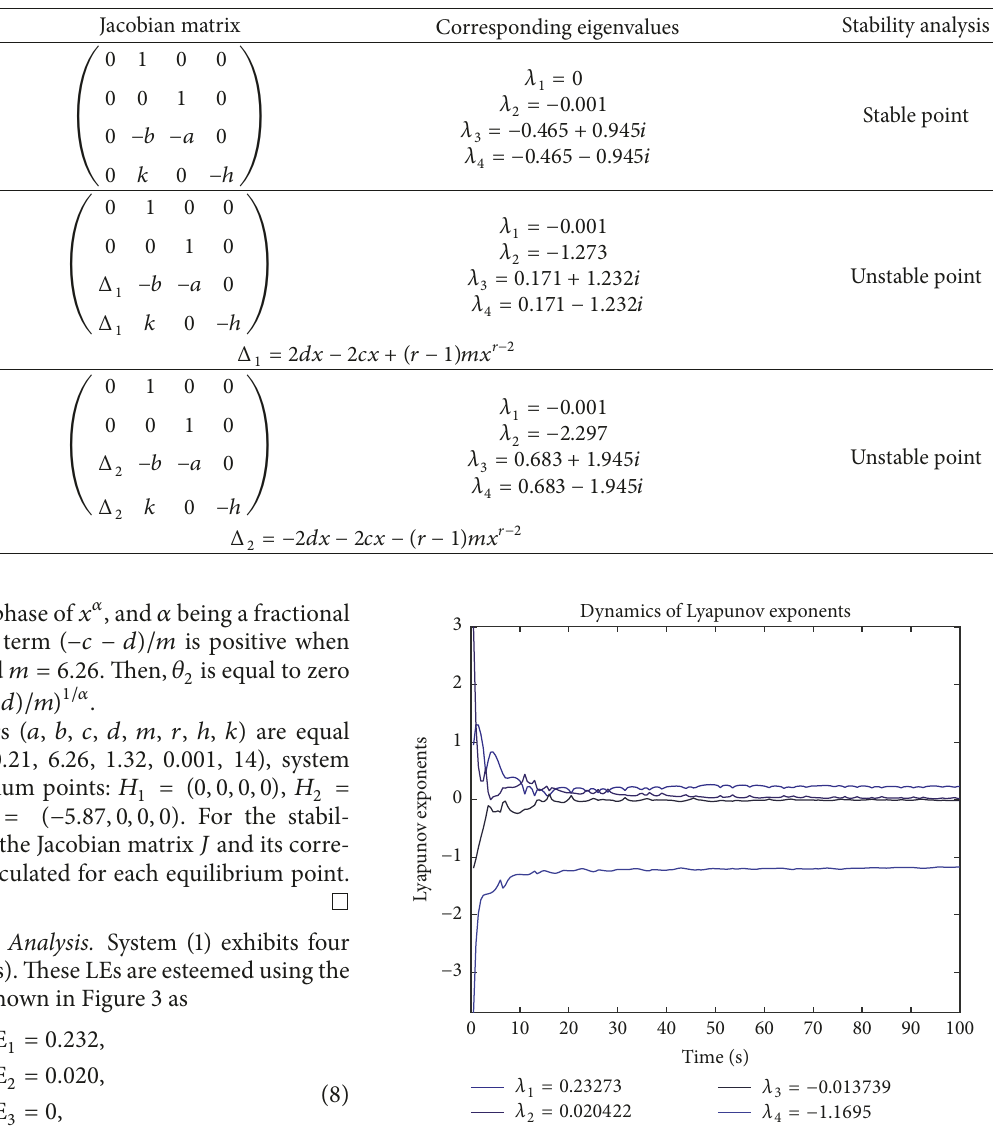
Table 1: Stability analysis of system (1).